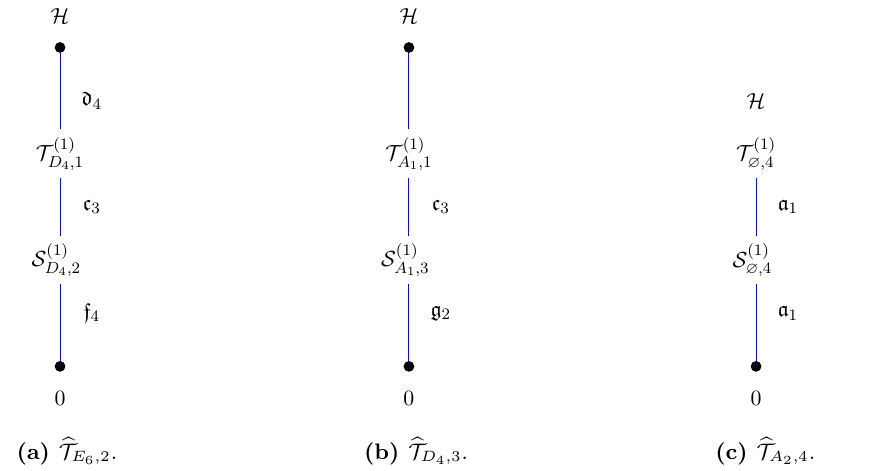
Figure 12. Higgs branches of the N = 2 SCFTs obtained by mass deforming (a) T (2) and (c) T (2) A 2 ; 4